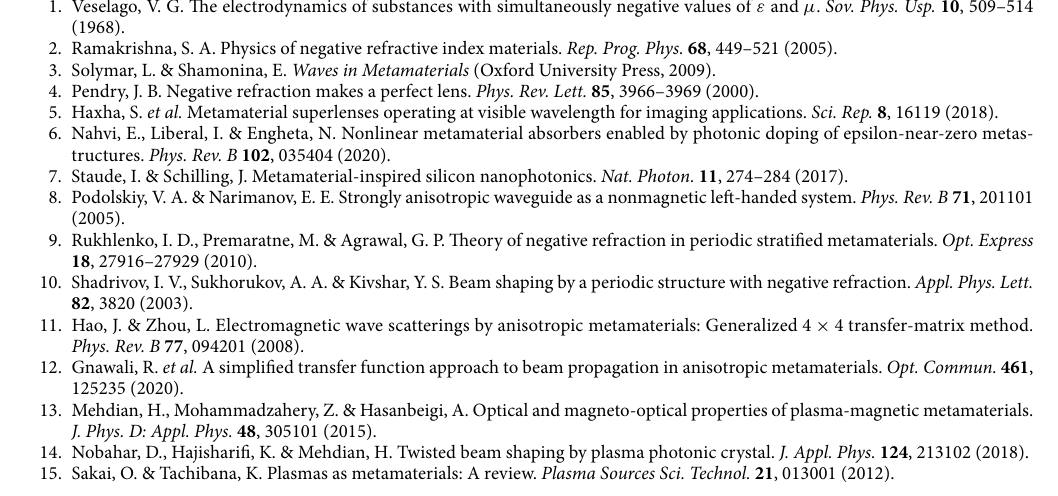
3 . The insets represent intensity distributions of output VB in (a) normal and (b) oblique −